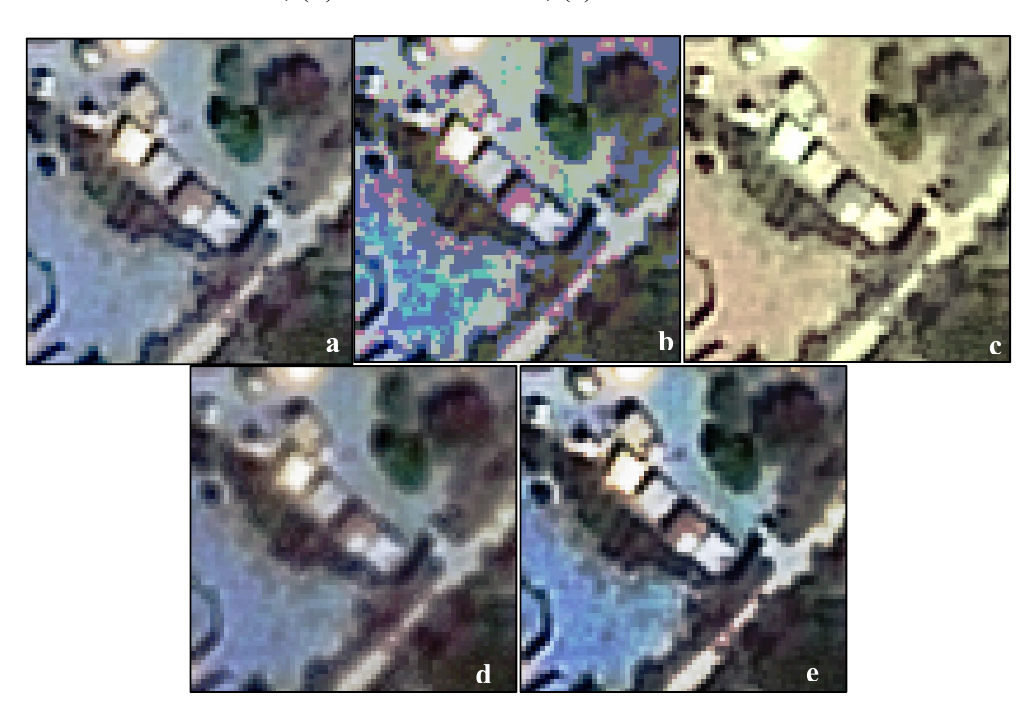
Figure 5. Output imagery from four data transformation functions tested in this work as part of a combined search space: ( a ) No Transformation, ( b ) Spectral Split, ( c ) Transformation Matrix, ( d ) Genetic Contrast, ( e ) Genetic